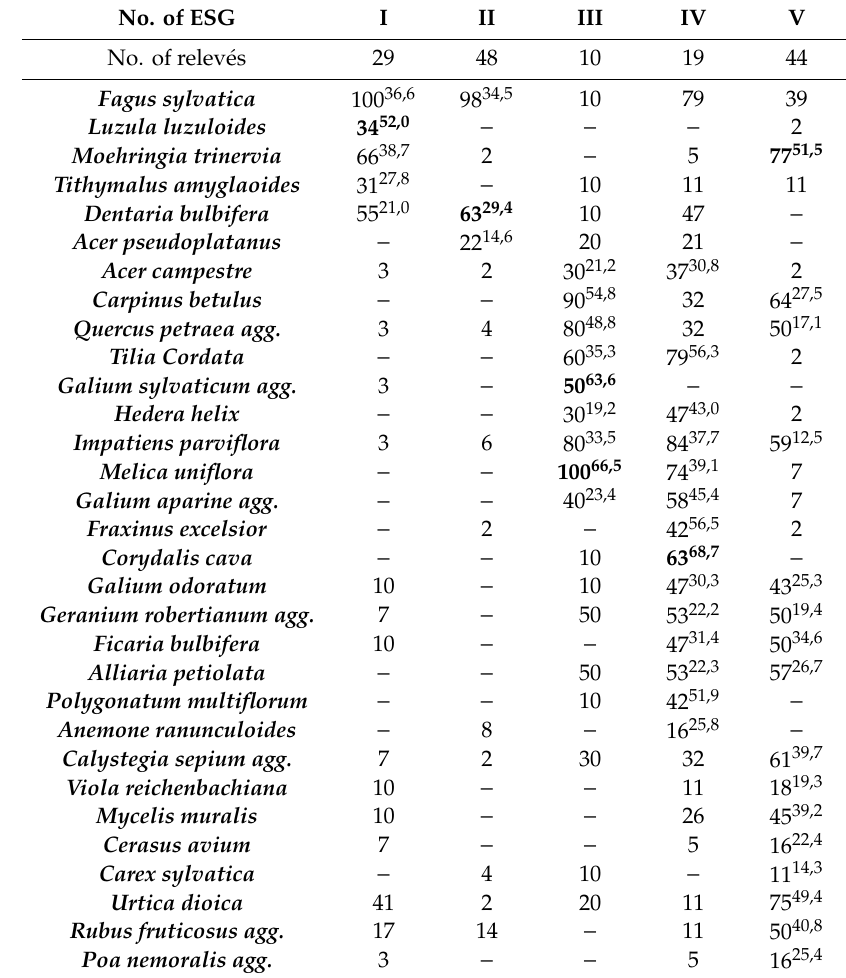
Table 1. Synoptic table of percentage frequency (constancy) and fidelity (phi coe ffi cient, upper indices). Only diagnostic species for specific vegetation groups with phi coe ffi cient ≥ 0.25 are shown in the